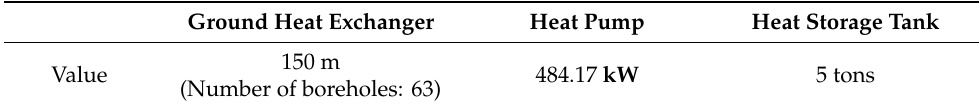
Table 4. Initial design values of the